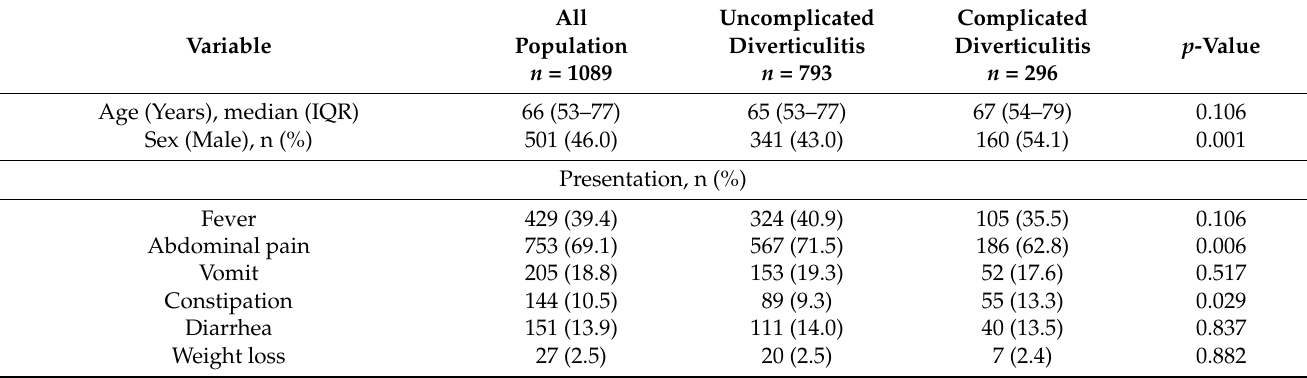
Table 1. Comparison of demographic and clinical characteristics between patients with complicated and uncomplicated diverticulitis at emergency department